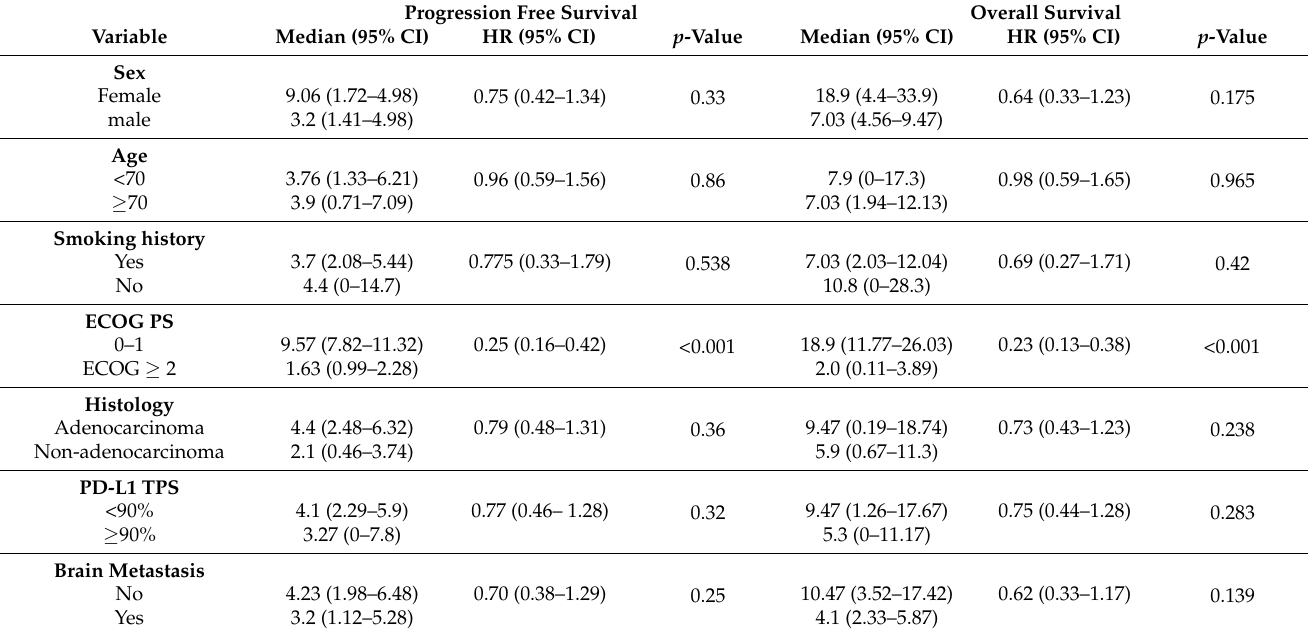
Table 5. Univariate analysis of progression-free survival and overall